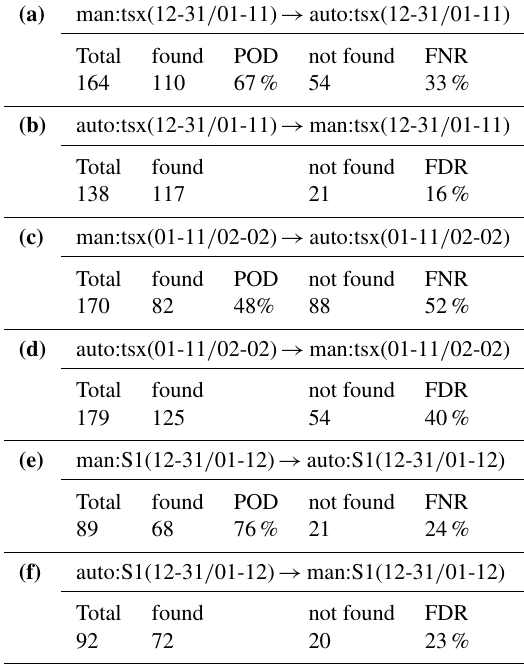
Figure 10. (a) Classification of mapped avalanche area into size classes according to Bühler et al. (2019). (b) The cumulative A i ) plotted over avalanche size ( A i ) reveals that avalanche area ( (cid:54) i 1 the smallest avalanche size detected by TSX and SPOT-6 is about 500m 2 , 2000m 2 for S1, and around 1000m 2 for the automatic methods. The total cumulative areas differ by an order of magni- tude: with radar only bright deposit areas of new avalanches were mapped automatically (1 . 3 × 10 6 m 2 ), and less-bright areas were added manually (2 . 5 × 10 6 m 2 ). Summing all classes (new, old, un- sure) in TSX images results in 7 . 5 × 10 6 m 2 , which is one-third of the cumulative area of the SPOT-6 outlines (2 . 5 × 10 7 m 2